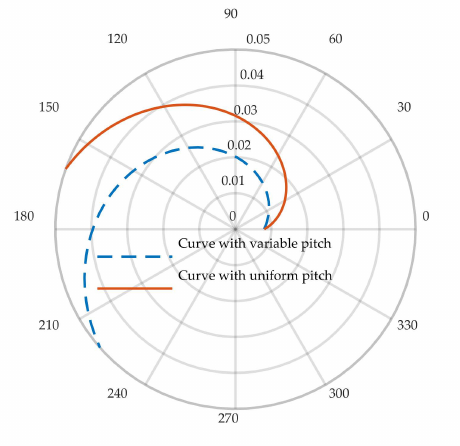
Figure 8. Comparative analysis of the pitch curve shape.